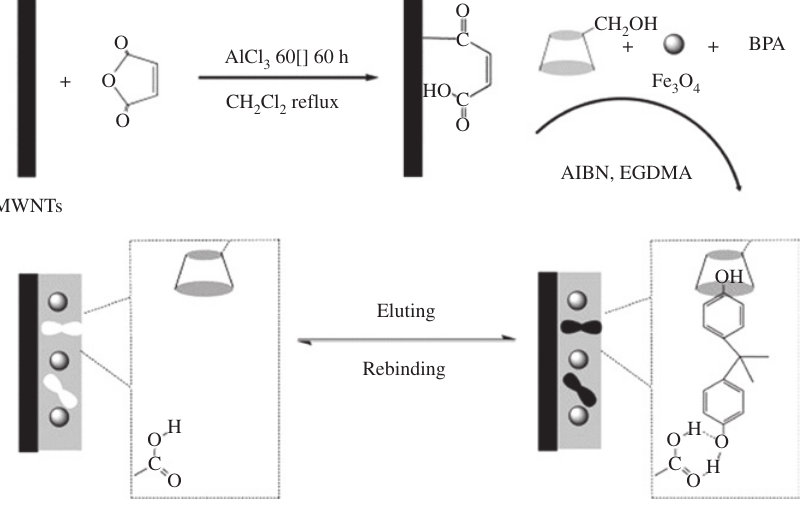
Figure 4: The protocol for synthesis of MIPs based on multiwalled CNTs. This figure was reproduced from Zhang et al. (2014) with permission from Elsevier.